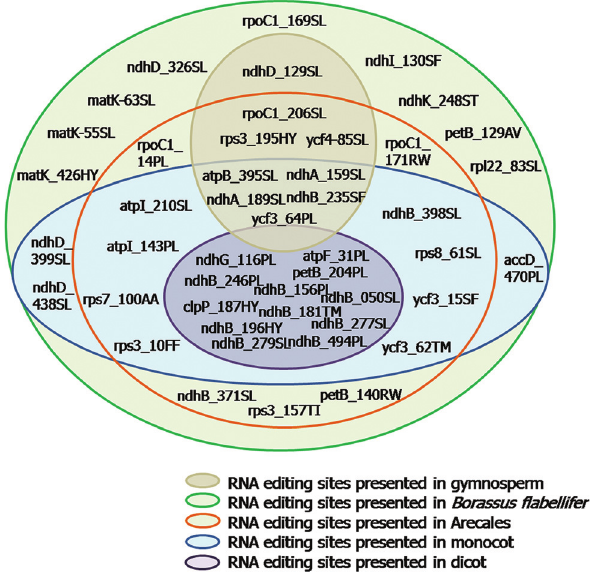
Figure 3 - Comparisons of 46 RNA editing sites observed in B. flabellifer to those observed in other 16 plants, which include gymnosperms, dicots, monocots and